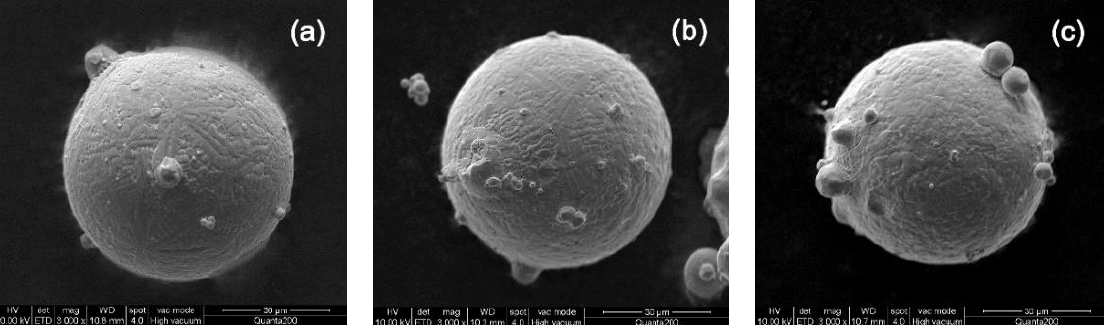
Figure 4. Surface morphology of superalloy powder for different exposure time in air: ( a ) 0 h; ( b ) 720 h; ( c ) 1440 h.